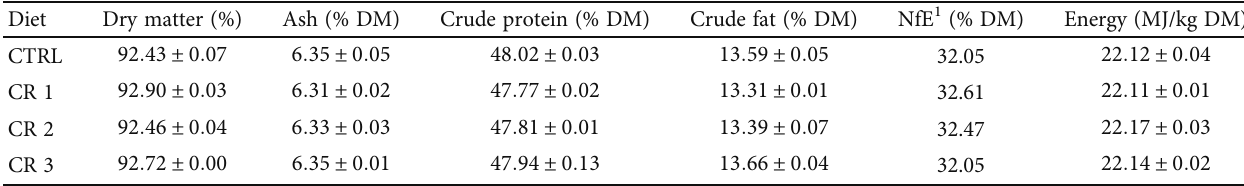
Table 2: Crude nutrient and gross energy content of diets ( mean ± SD ).